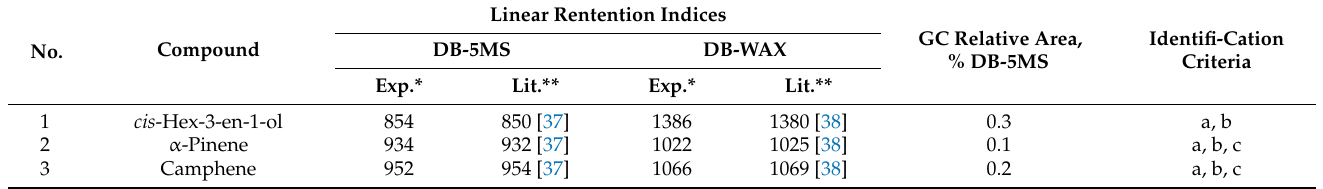
Table 1. GC/MS characterization of the essential oil obtained by steam distillation of aerial parts of Lippia alba , carvone chemotype (Verbenaceae